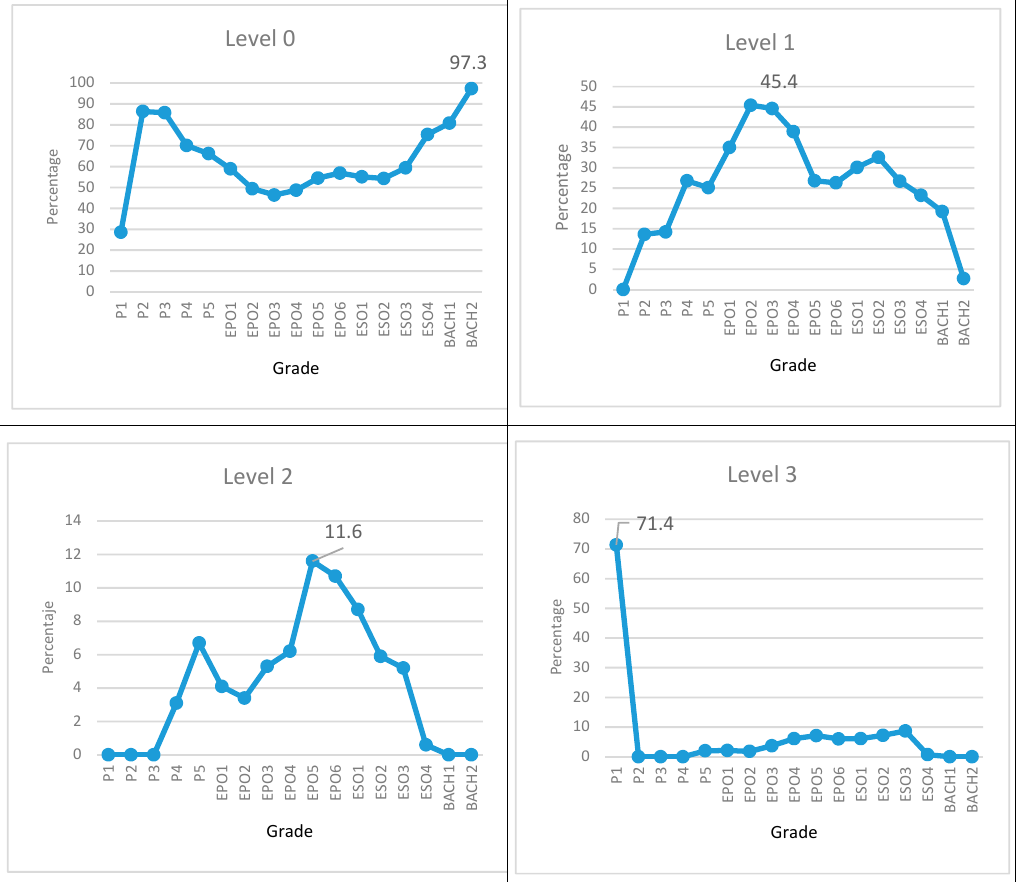
Figure 4. Percentage of students in each school grade per asterisk level.